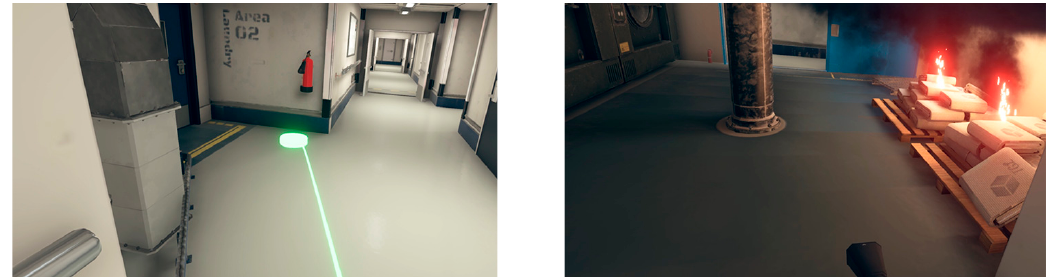
Figure 6. Trainee in the ship corridor and inside where the laundry is on fire.